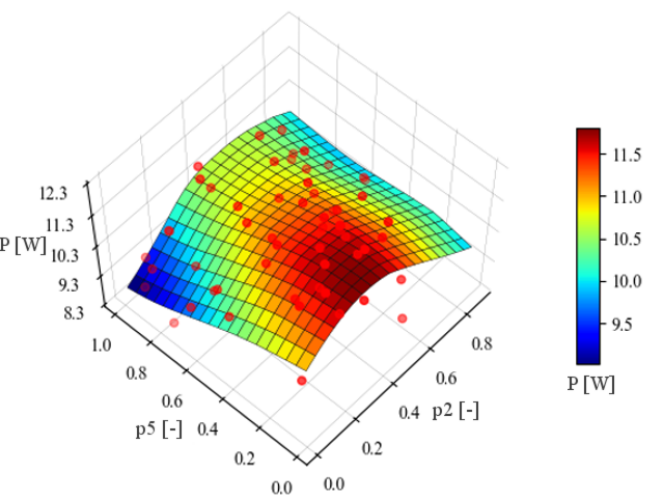
Figure 21. Representation of parameters p 2 and p 5 with response